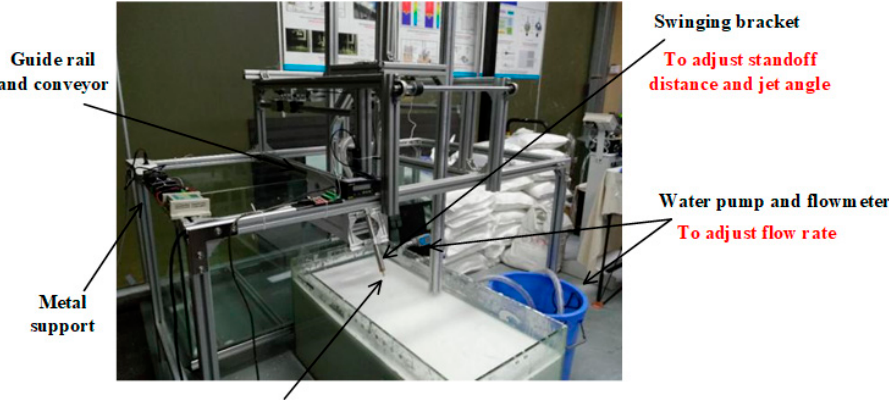
Figure 18. The experimental platform for soil-breaking of hydraulic jet.